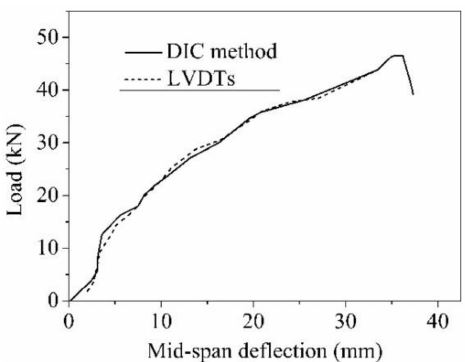
Figure 11. Comparison of deflection from digital image correlation (DIC) method and linear variable differential transformers (LVDTs) (SSC-12).